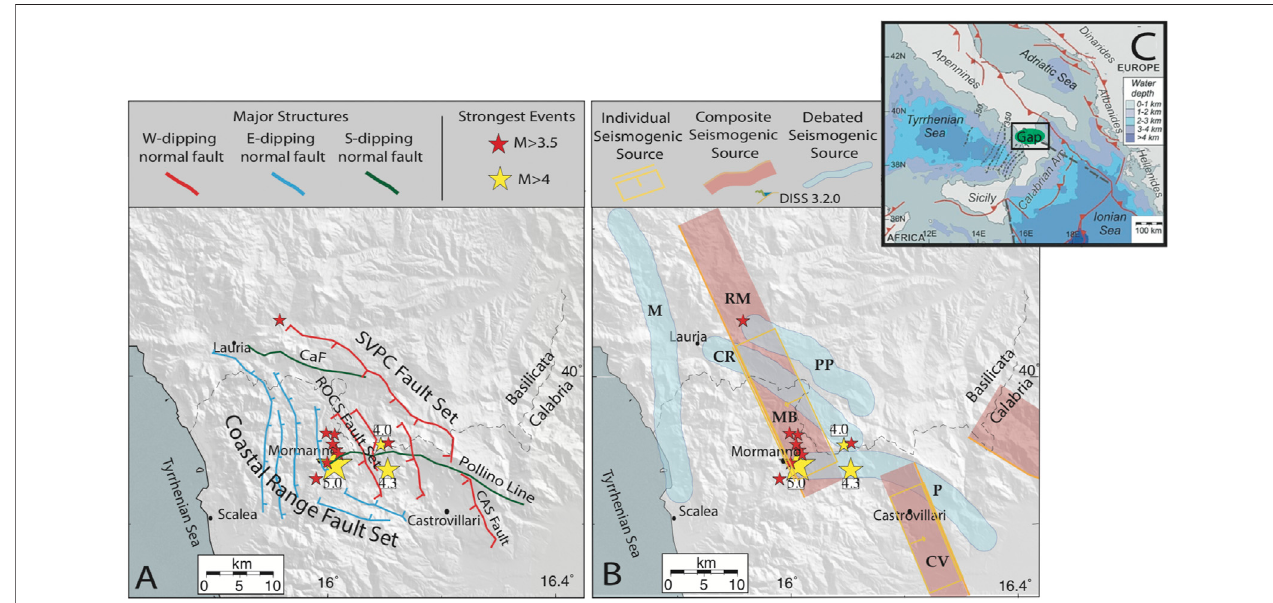
FIGURE 1 | (A) Detailed map of active faults, in the Calabria-Basilicata border region (modi fi ed after Brozzetti et al., 2017) and their interaction with Pollino 2010 – 2014 swarmstrongest events. Major structures arerepresented by: Coastal Range Fault Set (CRFS); Castello Seluci-Viggianello-Piano di Pollino-Castrovillari Fault Set (SVPC); Castelluccio Fault (CaF); Rotonda-Campotenese Fault Set (ROCS); Castrovillari Fault (CAS); Pollino Line (P). (B) Main seismogenic sources reportedintheItaliandatabaseoftheIndividualSeismogenicSources,DISSversion3.2.0(DISSWorkingGroup 2018).AccordingtoDISS,Pollinoseismicityis located between the Castrovillari (CV) seismogenic source to the South and the “ Rimendiello – Mormanno ” Mecure Basin (RM – MB) source to the North. Other major seismogenic sources, even if classi fi ed as debated, such as the Castelluccio – Rotonda (CR) fault, the Piana Perretti (PP) fault, and the Pollino (P) fault are also identi fi ed in the area. Yellow stars represent the strongest earthquakes recorded during the seismic sequence, M L 5.0 on October 25th, 2102, M L 4.3 in May 28th, 2012, and M L 4 on June 06th, 2014. Red stars represent events greater than M 3.5. (C) Geodynamic setting of the central Mediterranean, modi fi ed after Ferranti et al. (2014), is also